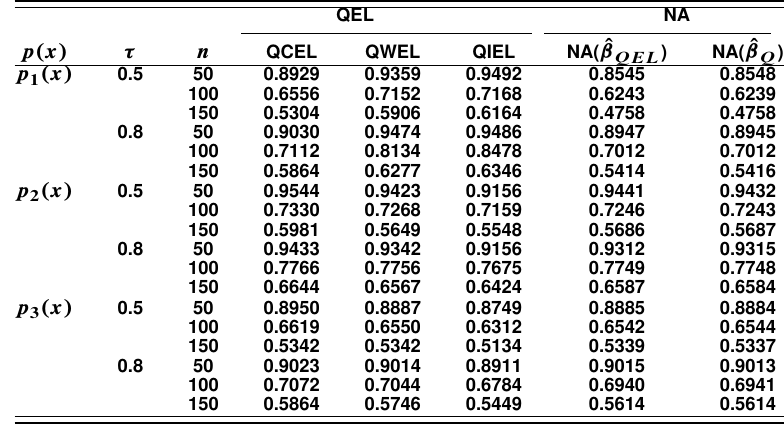
Table 1. Average lengths of the confidence intervals for ˇ in Model 1 for different forms of the selection probability function p.x/ and different values of sample size n and the quantile level (cid:28) under the nominal level 0:95 .